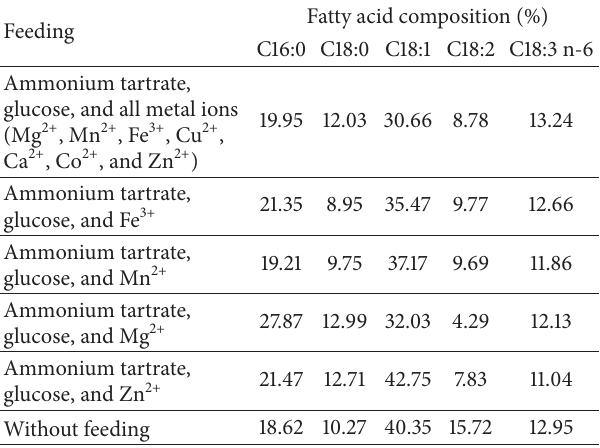
Table 2: Fatty acid composition of the cellular lipids of C. bainieri 2A1 at 120 hours of